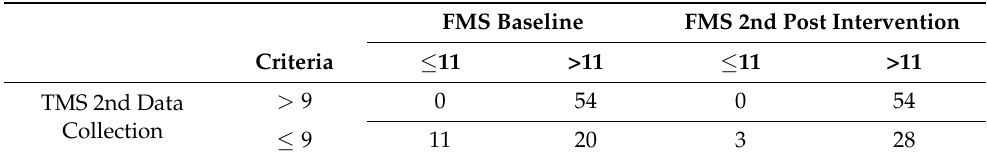
categories considering the first and second data collections for